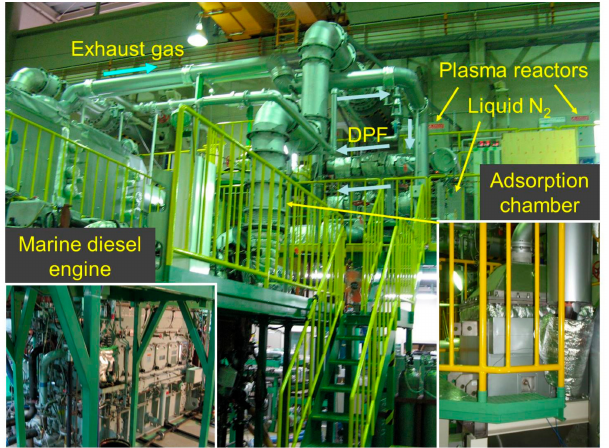
Figure 4. Photograph of the experimental setup for exhaust-gas aftertreatment in the marine diesel engine